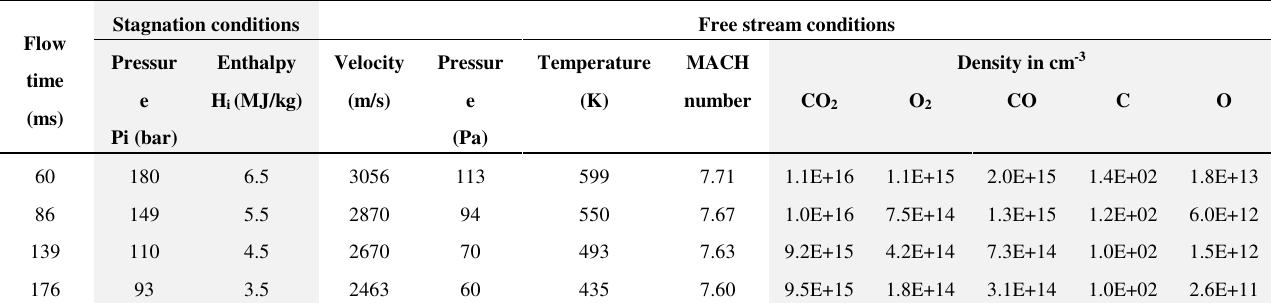
Table 2. Numerical flow rebuilding values for four instants of F4 run